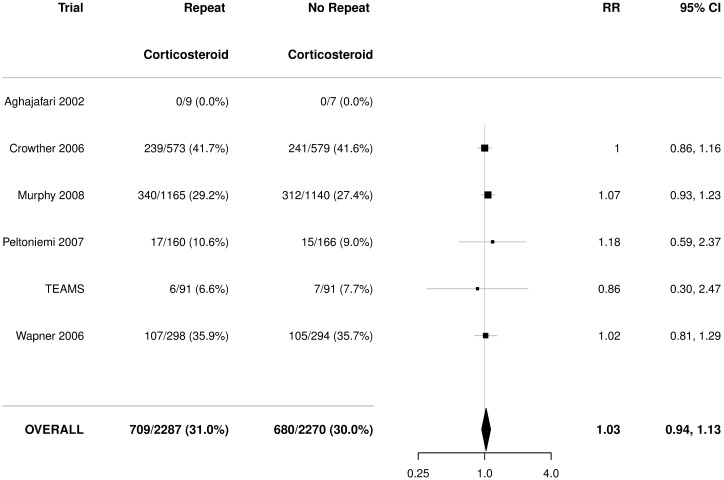
Primary outcome for the child: Death or any neurosensory disability.Neurosensory disability at childhood follow-up defined as developmental delay or intellectual impairment (developmental quotient or intelligence quotient more than one standard deviation below the mean), cerebral palsy (abnormality of tone with motor dysfunction), blindness (corrected visual acuity worse than 6/60 in the better eye), or deafness (hearing loss requiring amplification or worse). Figures are numbers (percentages) with RR and 95% CI. p-value for heterogeneity 0.96. CI, confidence interval; RR, relative risk; TEAMS, Trial of the Effects of Antenatal Multiple courses of Steroids versus a single course.